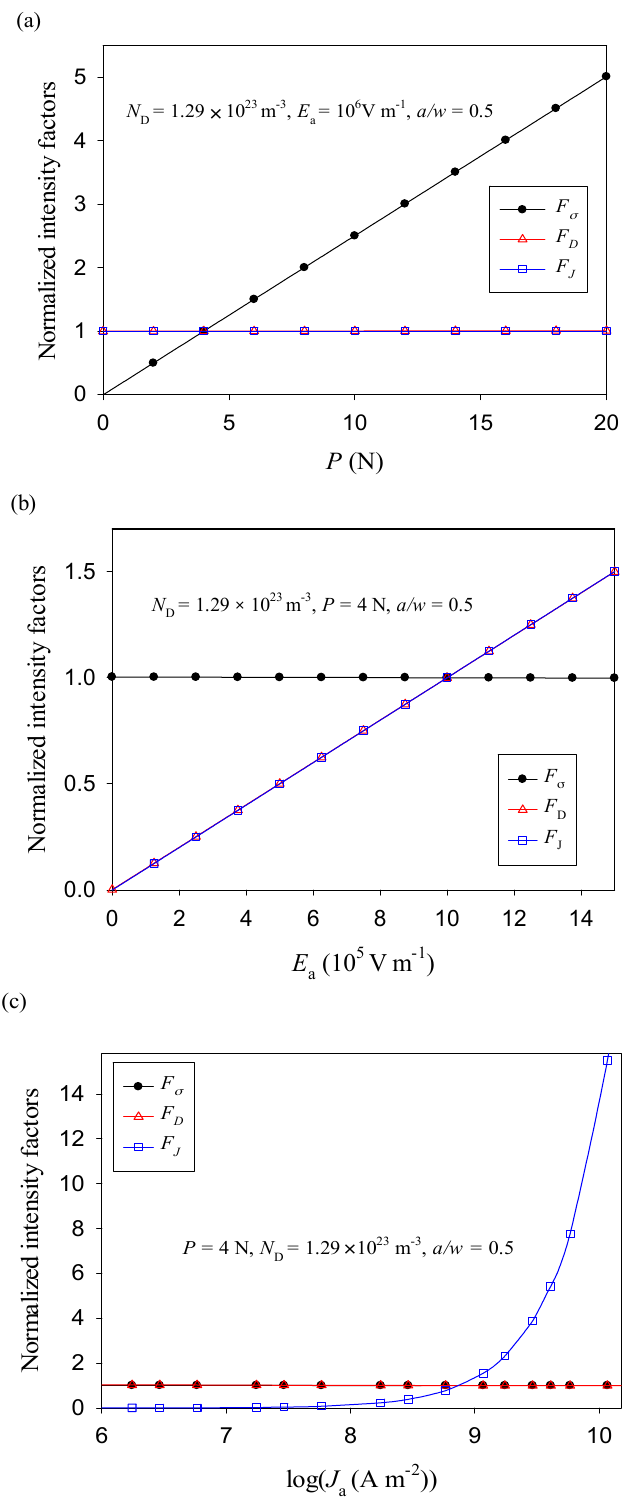
Figure 5. Normalized intensity factors versus loads under ( a ) the mechanical loading, ( b ) the electric field, and ( c ) the electric current density.